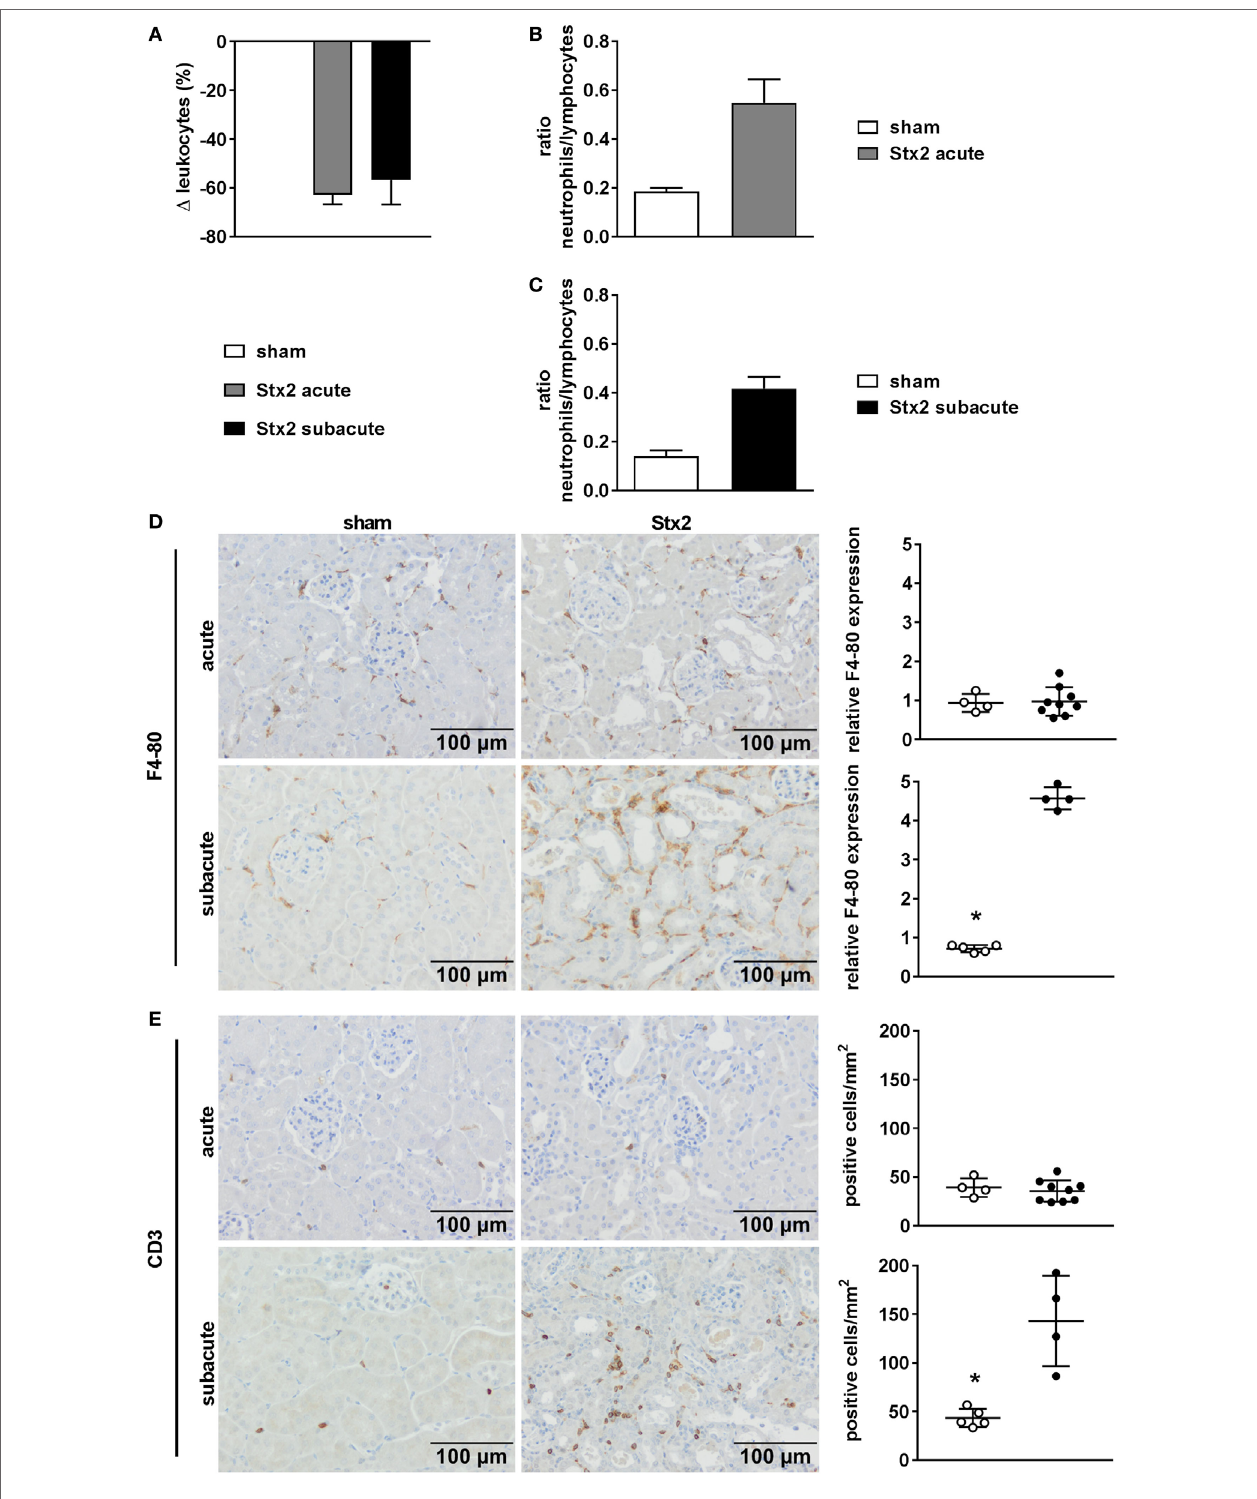
FigUre 5 | Immune response in C57BL/6J mice subjected to different Stx2 regimens. (a) Percentage change of leukocyte counts and (B,c) ratio of neutrophils to lymphocytes for the acute and subacute model compared with the respective sham group. (a–c) Data are expressed as mean ± SEM for n observations (acute: sham n = 6, Stx2 n = 11; subacute: sham n = 5, Stx2 n = 6). Representative images (scale bar 100 µm) of immunohistochemical detection and quantitative data of (D) F4-80 (surface antigen of macrophages) and (e) CD3 (surface antigen of T cells) in renal sections of C57BL/6J wild-type mice are depicted (acute: sham n = 4, Stx2 n = 9; subacute: sham n = 5, Stx2 n = 4). * p < 0.05 for sham (white dots) vs. Stx2 (black dots; t -test).